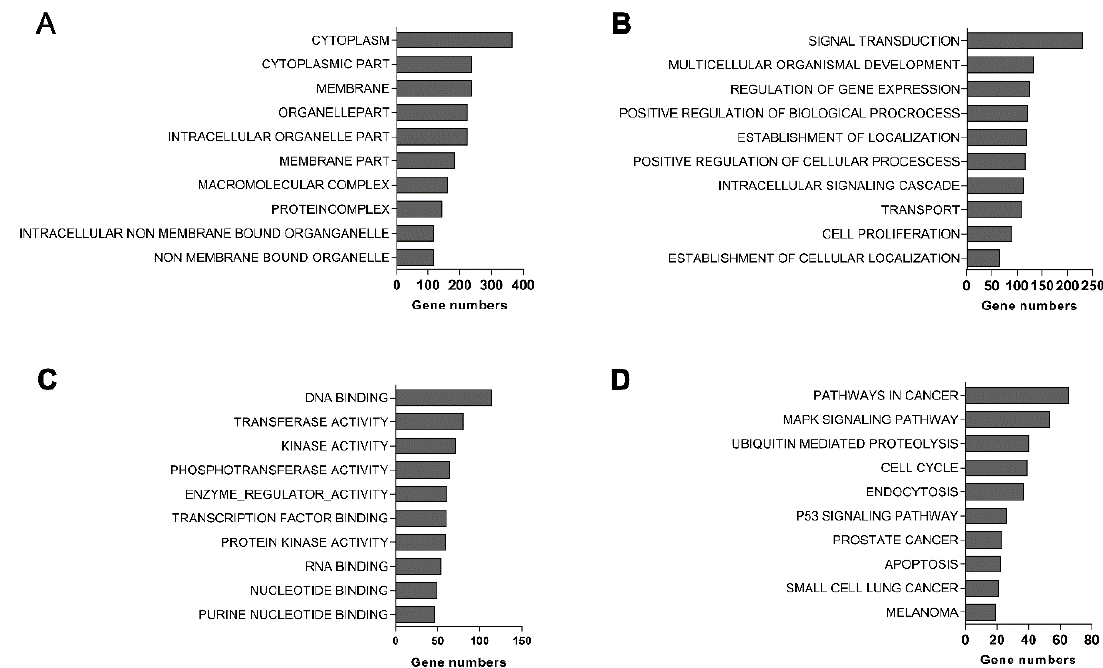
Figure 6. GO and pathway analysis of differentially expressed genes. ( A ) The main cellular component of differentially expressed genes by GO analysis; ( B ) the main biological processes of differentially expressed genes by GO analysis; ( C ) the main molecular functions of differentially expressed genes identified by GO analysis; and ( D ) pathway analysis of differentially expressed genes.